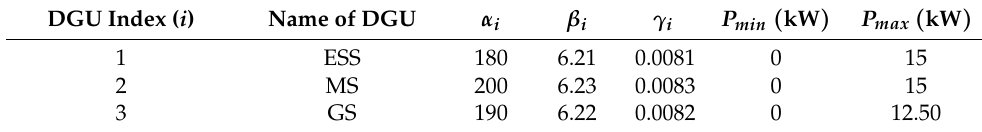
Table 1. Cost parameters of the